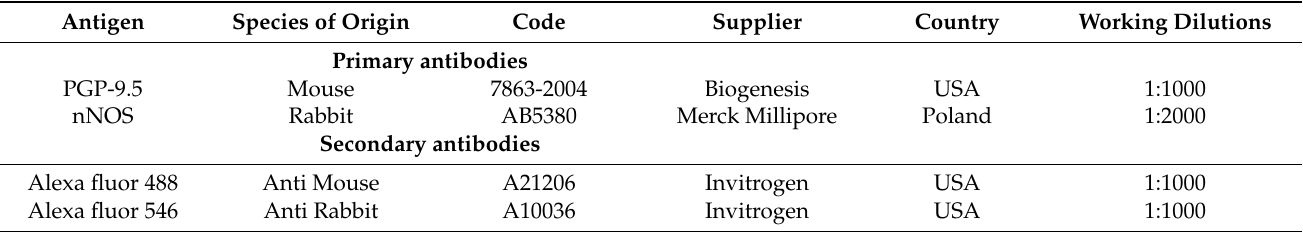
Table A1. Description of